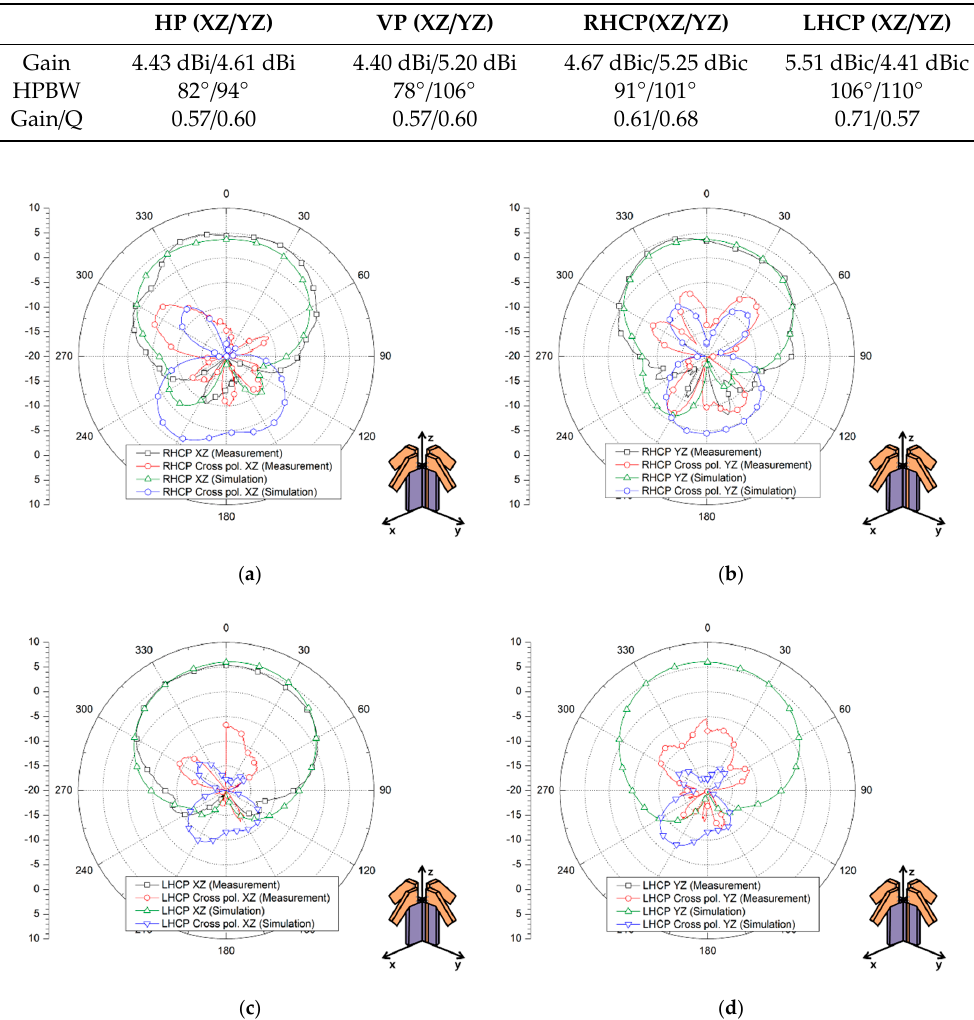
Table 2. Measured gain, the half-power beamwidth (HPBW), and Gain / Q ratio of the proposed antenna.